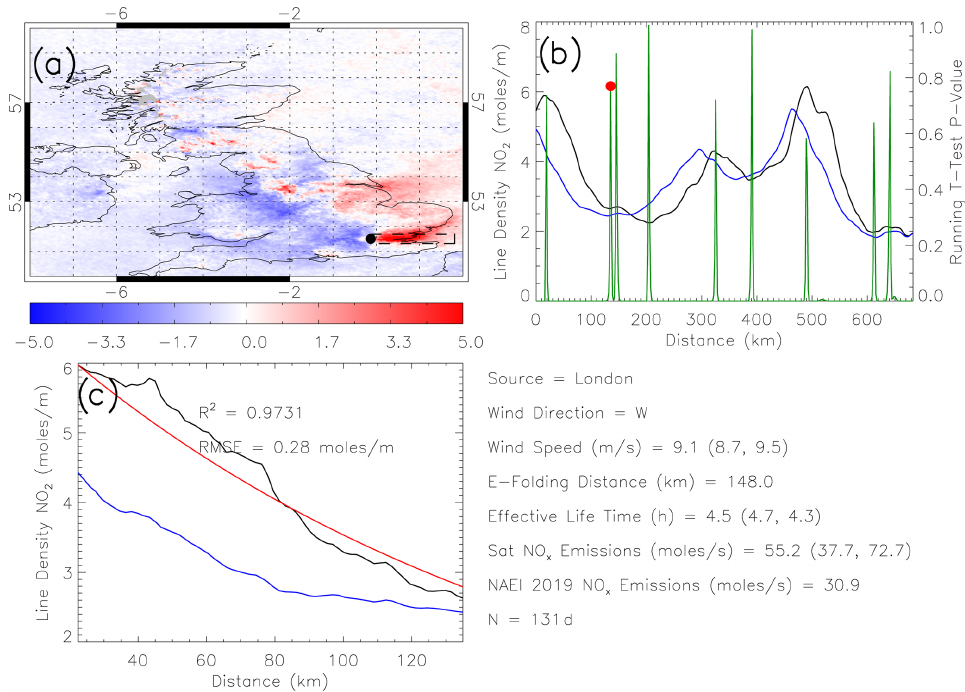
Figure 2. (a) TROPOMI TCNO 2 (10 − 5 molm − 2 ) sub-sampled under westerly flow (defined over London, black dot) minus the long-term average (February 2018 to January 2020). The dashed box represents the width of the source and distance between the source and background. (b) Downwind NO 2 LD from London (black: westerly flow, blue: all-flow average) with the corresponding running t -test p -value (green line). The red dot represents the location of the background level determined by the turning point in the running t -test p -value time series. (c) The westerly flow and all-flow NO 2 LD between the peak westerly flow NO 2 LD value and the background value. The red line represents the e -folding distance fit with the corresponding R 2 and root mean square error (RMSE) between the westerly flow NO 2 LD and fit profile. N represents the number of days classified under westerly flow over